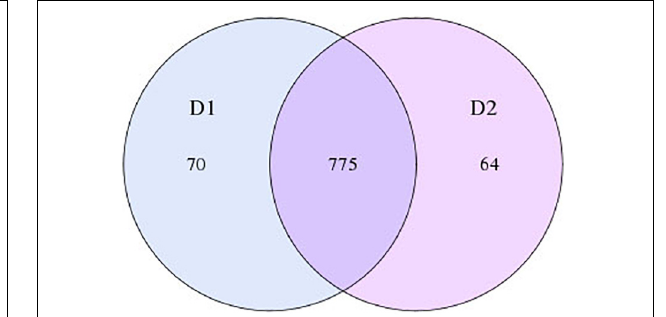
FIGURE 1 | OTU numbers of intestinal flora in the patients in the Electroacupuncture group before and after treatment (Z1, the Electroacupuncture group before treatment; Z2, the Electroacupuncture group after treatment; D1, the Control group before treatment; D2: the Control group after treatment).